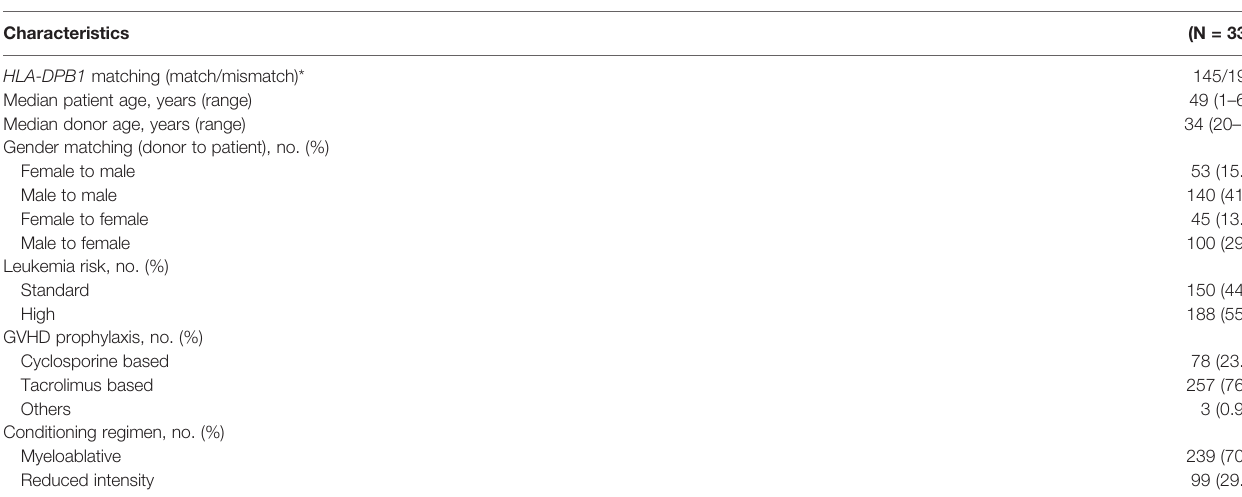
TABLE 1 | Patient and transplant